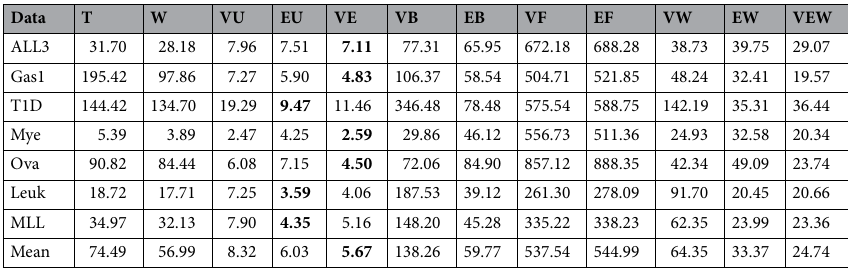
Table 5. Comparison of the running time ( 10 s ) between the VEW and other methods.